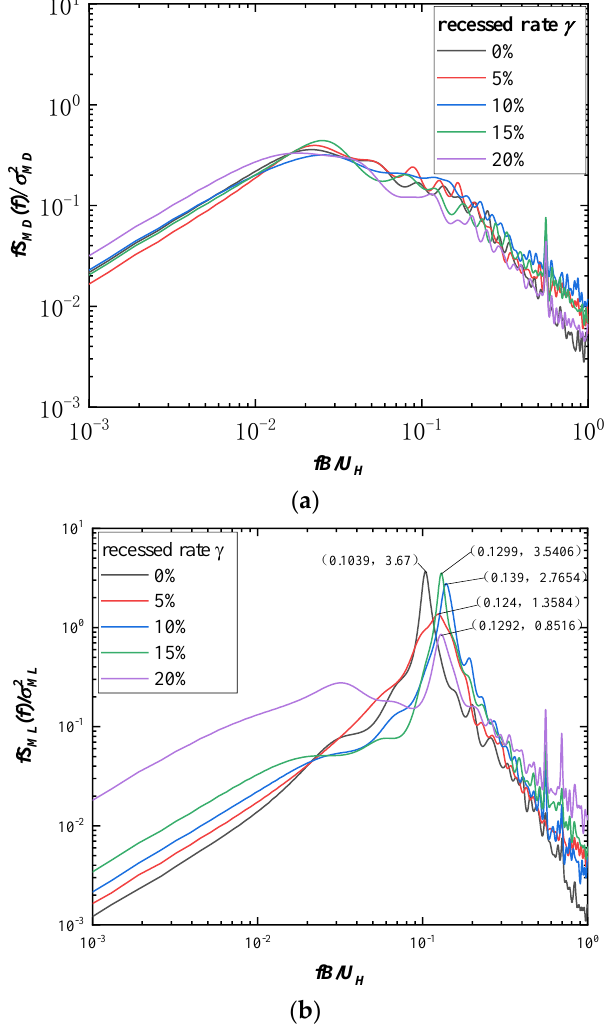
Figure 12. The base moment power spectra with reduced frequency. ( a ) The along − wind base moment power spectra. ( b ) The across − wind base moment power spectra.